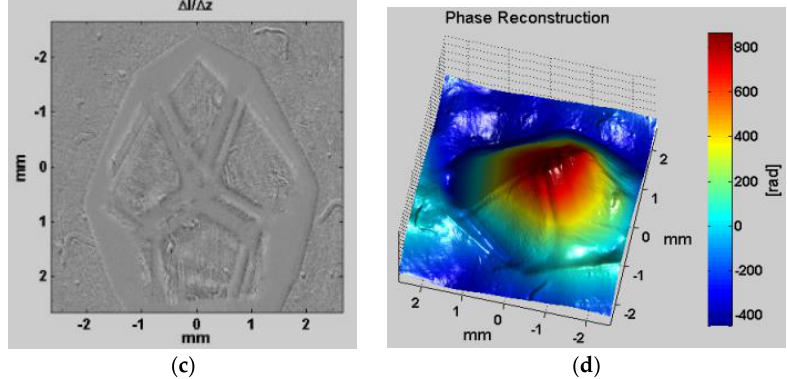
Figure 7. ( a,b ) Two intensity distributions of the diamond shape bead illuminated by a plane wave captured at the CCD as if 𝛥 z = ±0.5 mm, respectively; ( c ) derivative of intensity over the propagation direction; and ( d ) the reconstructed phase profile of the object at the CCD camera.